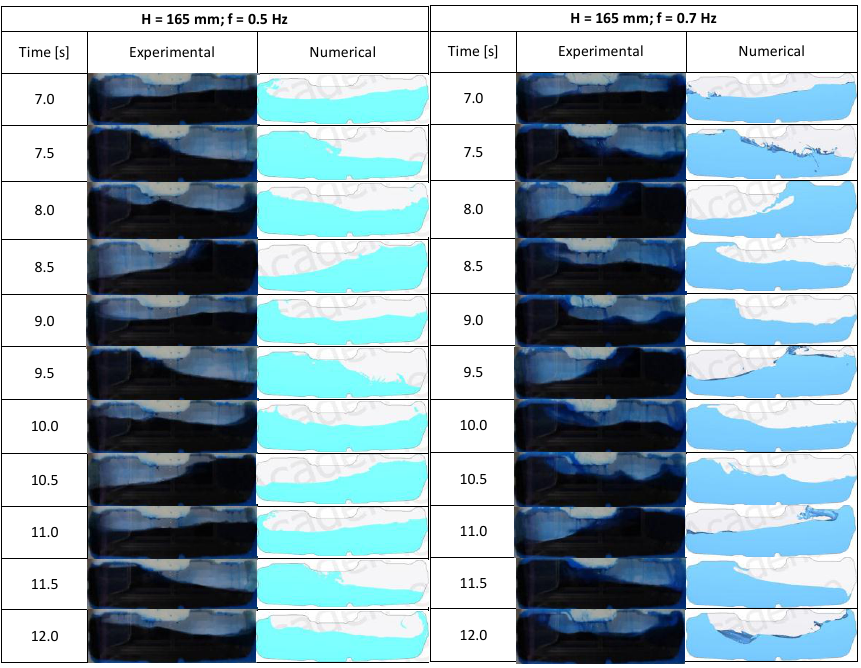
Table 6. Model output for the center of gravity (Test 3) . Frequency